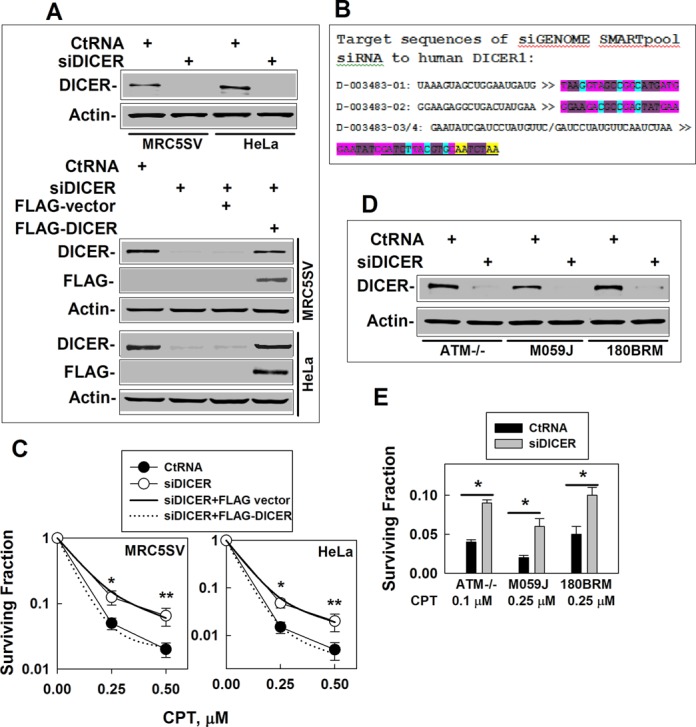
Knockdown of DICER causes human cells to become resistant to CPT, a DNA damage inducer. (A) MRC5SV and HeLa cells were collected at 60 h after transfecting with control RNA (CtRNA), siRNA pool against DICER (siDICER), FLAG vector, FLAG-DICER or combining transfection. Whole cell lysates were prepared for immunoblot detection. (B) Strategy for generating FLAG-DICER construct that is resistant to the pool of siRNA (containing 4 siRNA sequences) against hsa-DICER. (C) The effects of knockdown of DICER on cell sensitivity to CPT. MRC5SV and HeLa cells were treated with different concentrations of CPT for an additional 18 h when DICER was knocked down as described in (A). The cells were collected for a clonogenic assay. The data presented are the mean and SD from three independent experiments that the authors carried out, *P < 0.05, **P < 0.01. (D) Immunoblot detection was performed of ATM−/−, M059J or 180BRM cells treated with siDICER as described in (A). (E) Clonogenic data were obtained from ATM−/−, M059J or 180BRM cells treated with CPT (0.1 μM for ATM−/− cells and 0.25 μM for M059J or 180BRM cells) for 18 h when DICER was knocked down as described in (C). The cells were collected for a clonogenic assay. The data presented are the mean and SD from three independent experiments that the authors carried out, *P < 0.05.